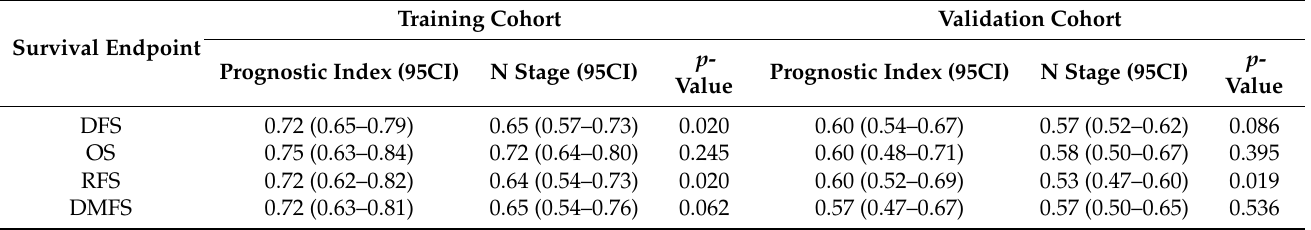
Table 3. Concordance index of the proposed geometric prognostic index and N stage in the training and validation